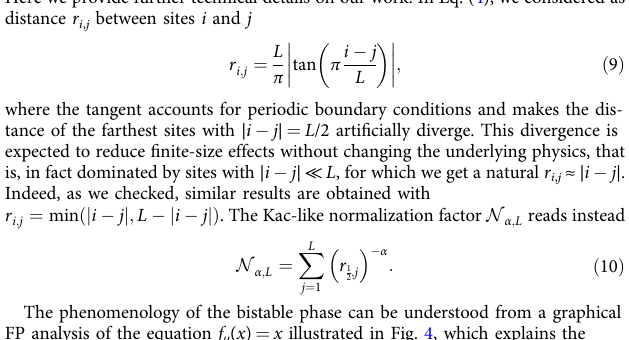
Fig. 4 Graphical fi xed-point analysis. For a power – law exponent α < 1, the dynamics of Eq. (6) is understood from the FP analysis of the equation x = f μ ( x ). ¼ 0 : 6550 ð 8 Þ , the system is inactive, corresponding to a single FP x 0 = 0: at long times, the system ends up in the empty, a For a control parameter μ < μ 0 c absorbing state with state variables s i = 0 for all sites i . b At the critical point μ ¼ μ 0 , a new semi-stable FP emerges at x c = 0.5216(9), that is, unstable c from his left and stable on his right. c Increasing μ above μ 0 , the semi-stable FP splits into an unstable FP x 1 < x c and a stable FP x 2 > x c . Depending on c whether the initial density p 1 is < x 1 or > x 1 , the system fl ows towards density n = x 0 = 0 or n = x 2 > 0, respectively, indicating